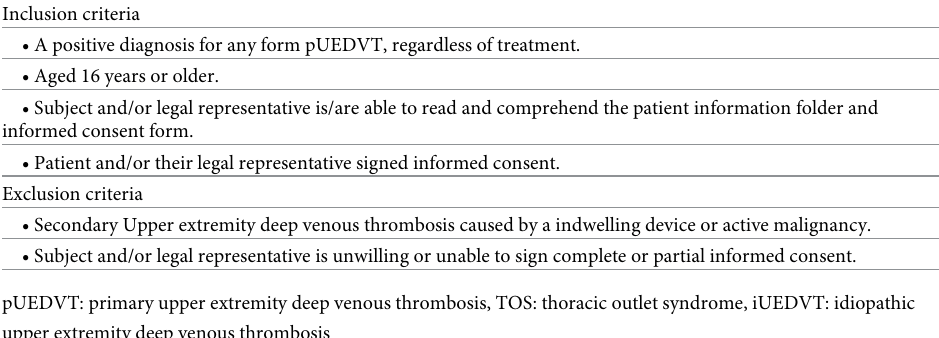
Table 2. In- and exclusion criteria for the TROTS registry, primary upper extremity deep venous thrombosis specific. Inclusion